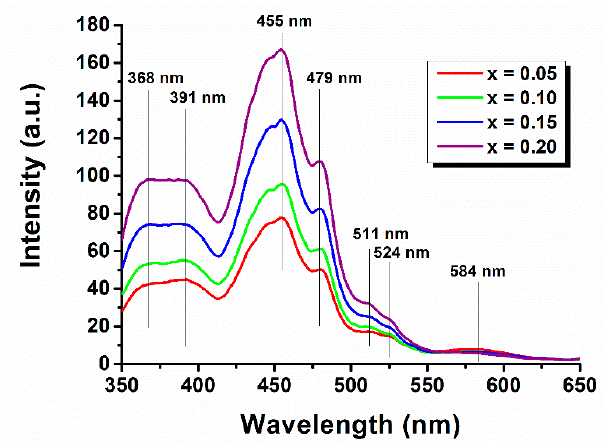
Figure 12. Fluorescence spectra for Bi 1 − x Eu x FeO 3 powders.